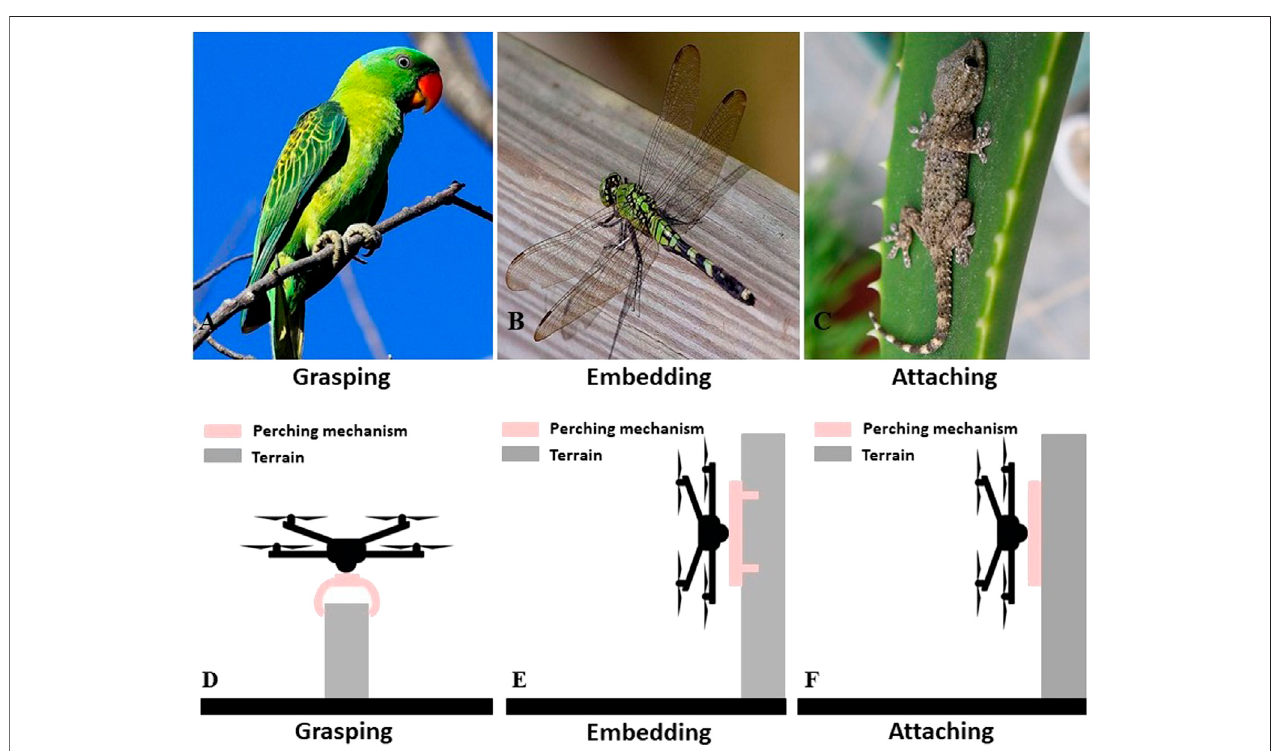
FIGURE1| Perchingbehavioursofdifferentcreaturesinnatureandaerialrobotswithdifferentperchingmechanisms: (A) demonstratesaparrotperchingonatree branch based on the grasping capability of its claws; (B) demonstrates a dragon fl y perching on a tree trunk based on the embedding capability of the spines on its feet; (C) demonstrates ageckoperchingonaglassbasedontheattachingcapabilityofits feet; (D) demonstrates anaerial robotperchingonapolebygrasping mechanism; (E) demonstrates an aerial robot perching on a wall by embedding mechanism, and (F) demonstrates an aerial robot perching on a wall by attaching mechanism.